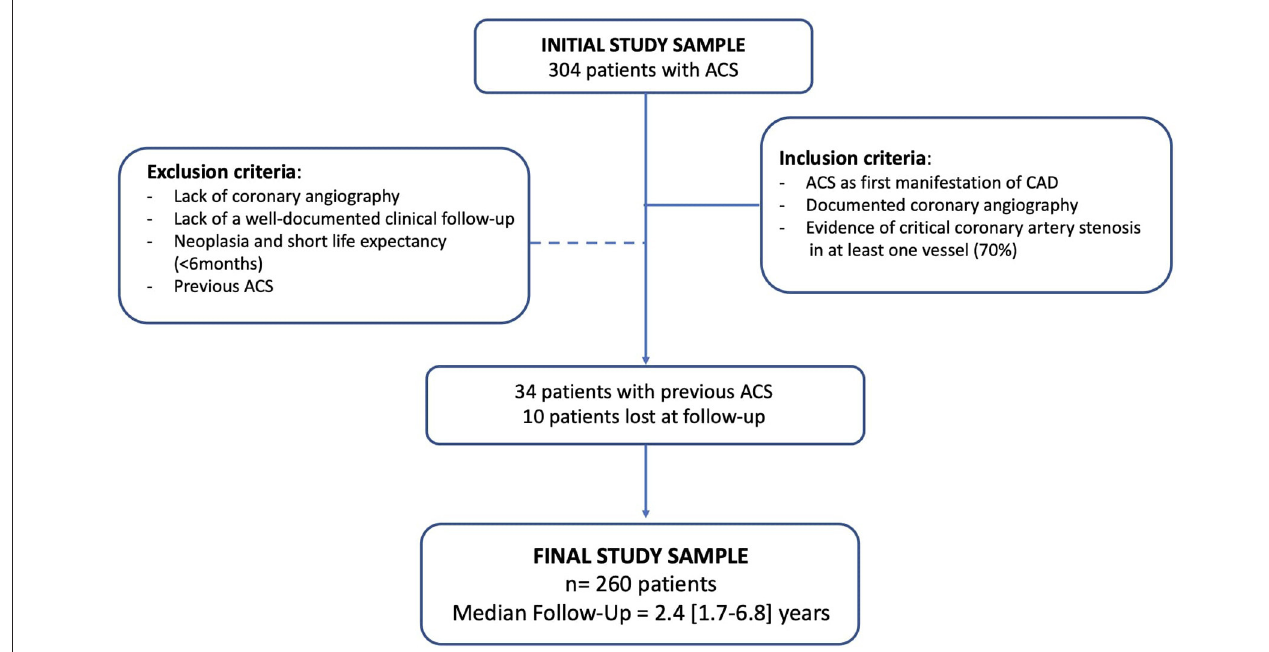
FIGURE 1 | Flow chart of the study. ACS, acute coronary syndrome; CAD, coronary artery disease.